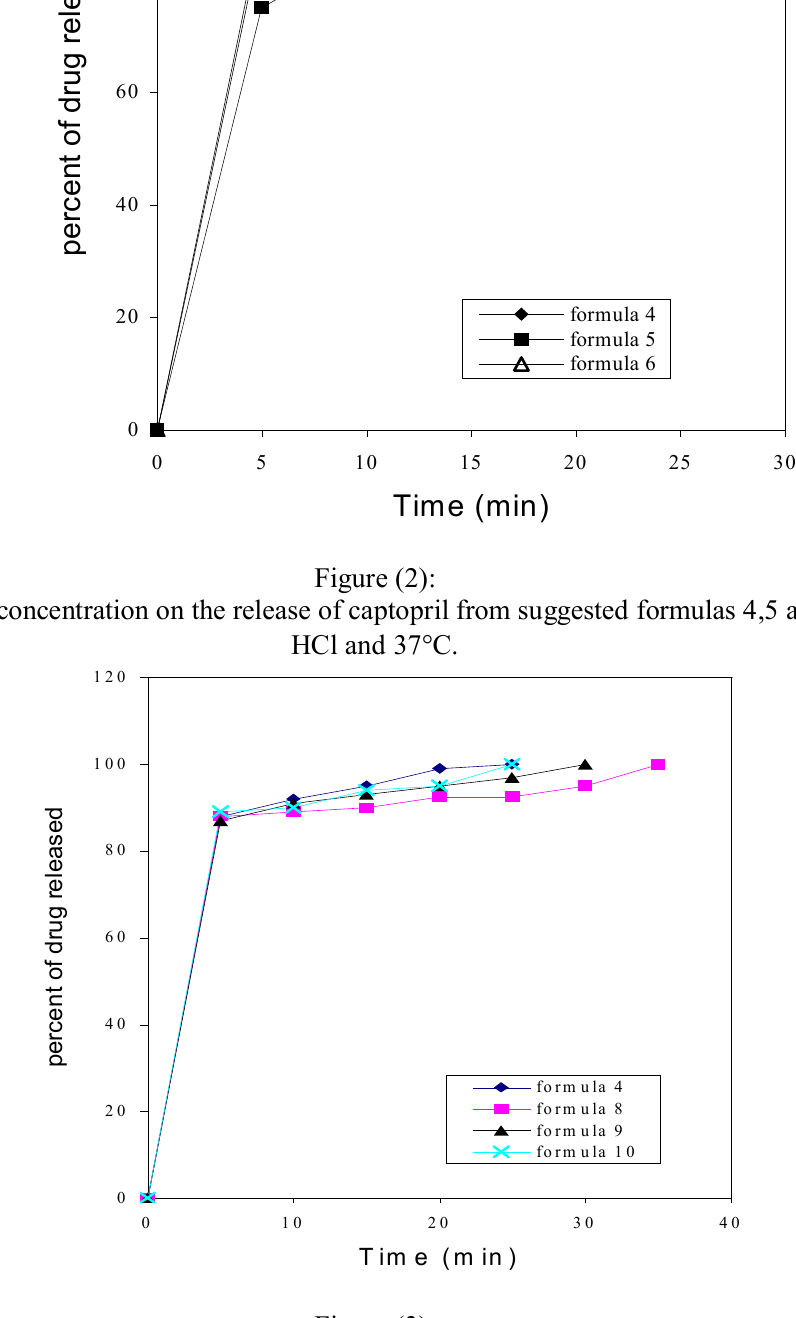
Comparison between the release of captopril from formulas containing starch intra, extra (4,8) and explotab intra, extra